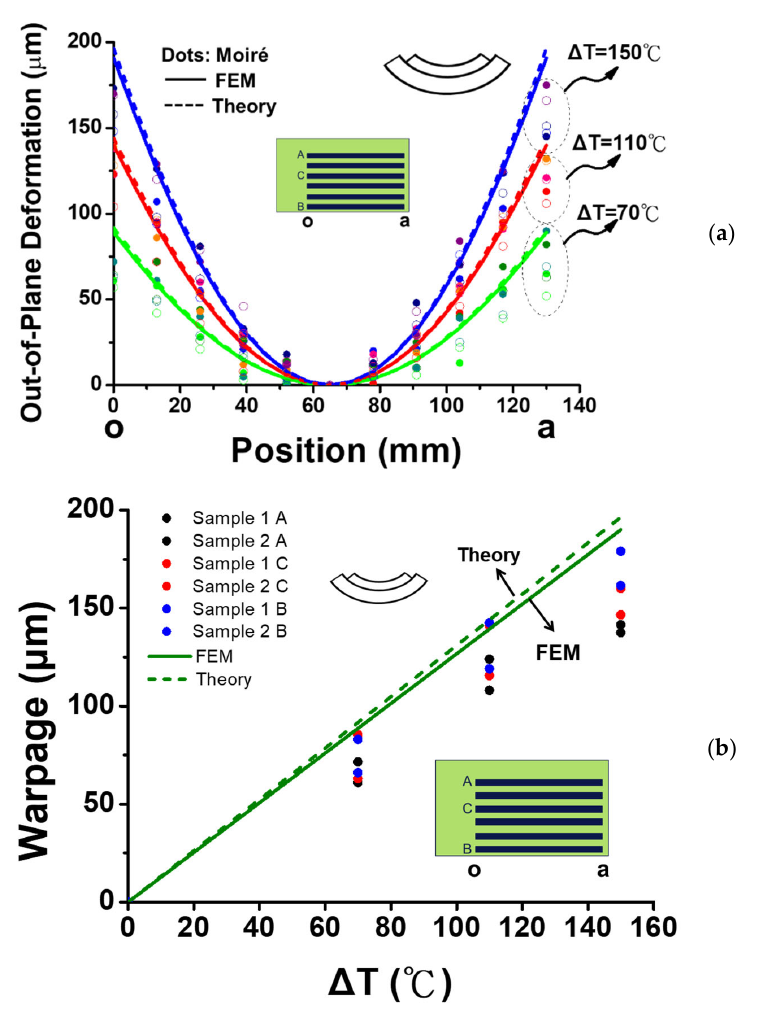
Figure 19. ( a ) Comparison of thermally induced deformations of the six-socket-PCB assembly along the socket lines (line o-a) at various temperature loadings ( Δ T), obtained from moiré measurements, theory, and FEM simulations, and ( b ) the corresponding warpage comparison of the six-socket-PCB assembly along the socket lines at various temperature loadings ( Δ T).